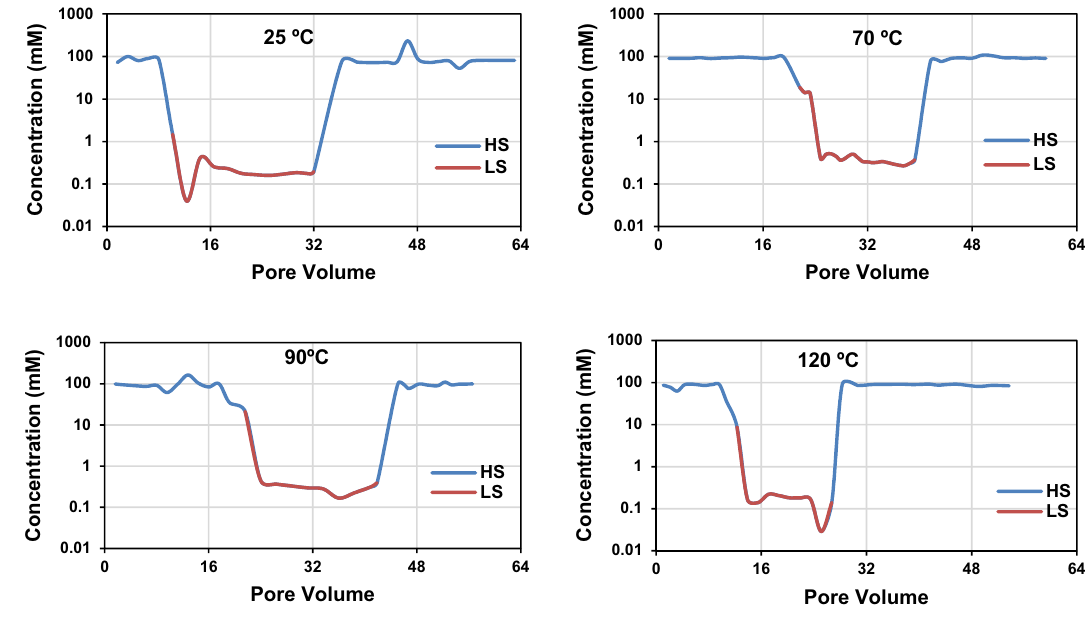
Fig. 3 Effluent concentrations of Ca 2+ from sand column at 25, 70, 90, and 120 °C